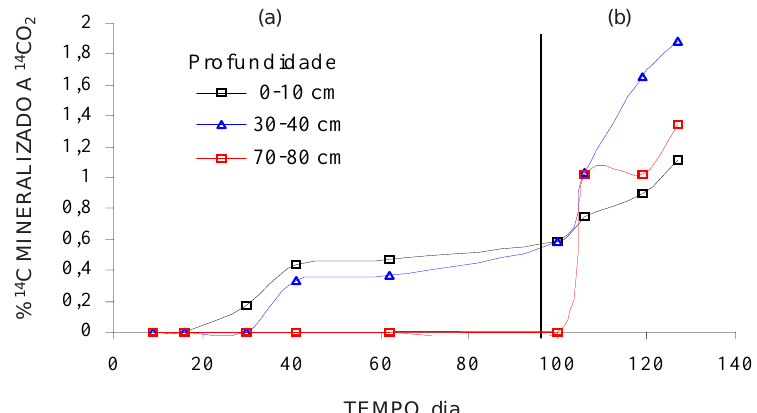
Figura 3. Mineralização de atrazina em amostras de Latossolo Roxo sob sistema de cultivo convencional. (a) período de incubação sem adição de composto orgânico e (b) período com adição de composto orgânico.